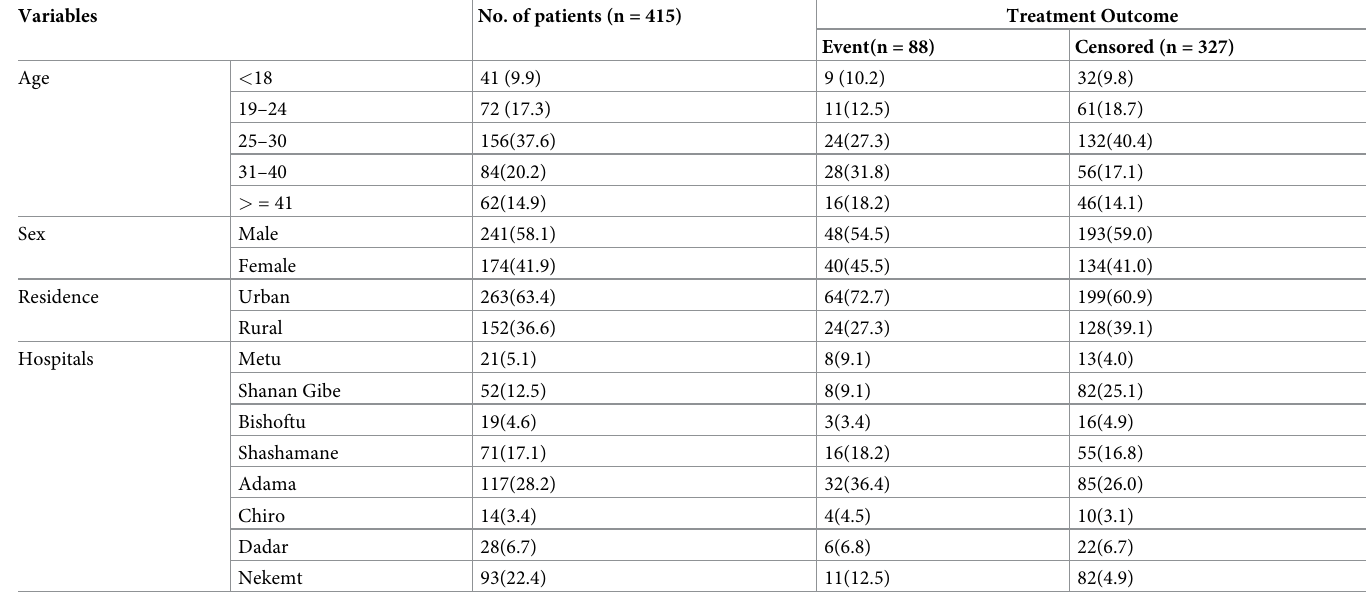
Table 1. Socio-demographic characteristics of MDR-TB patients stratified by treatment outcome in Oromia hospitals from 2012 to 2017, Oromia, Ethiopia. Variables No. of patients (n =